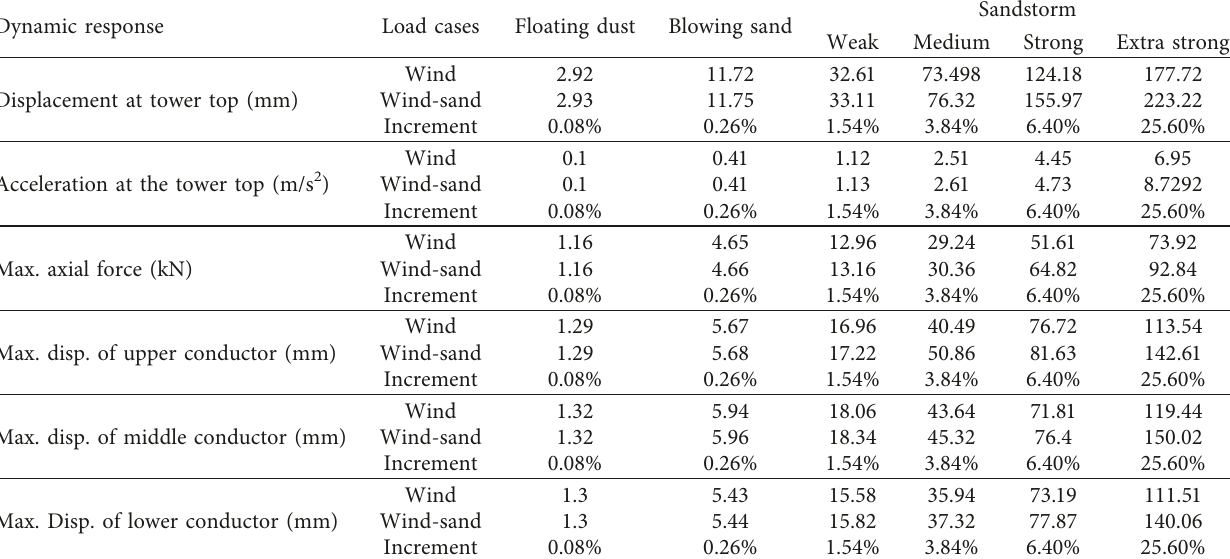
Table 4: Dynamic response value and growth